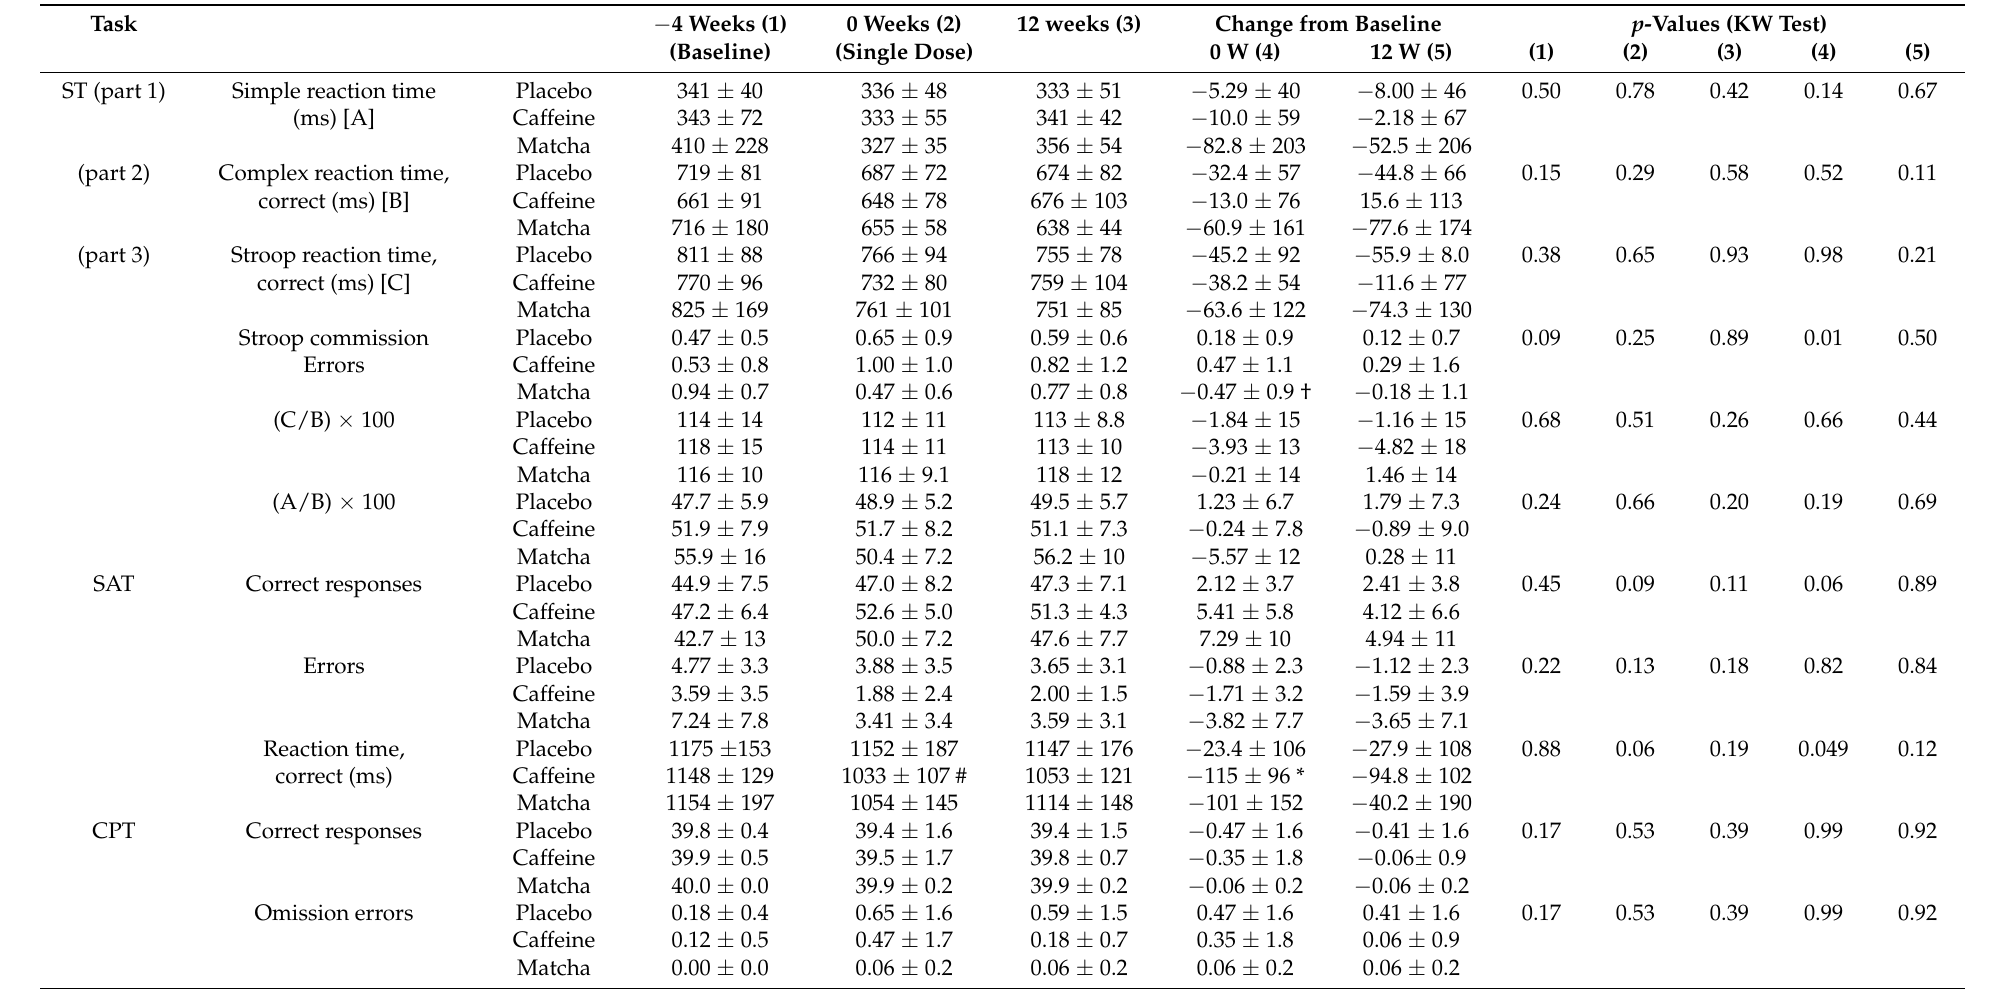
Table 5. Effect of matcha or caffeine intake on attention-related